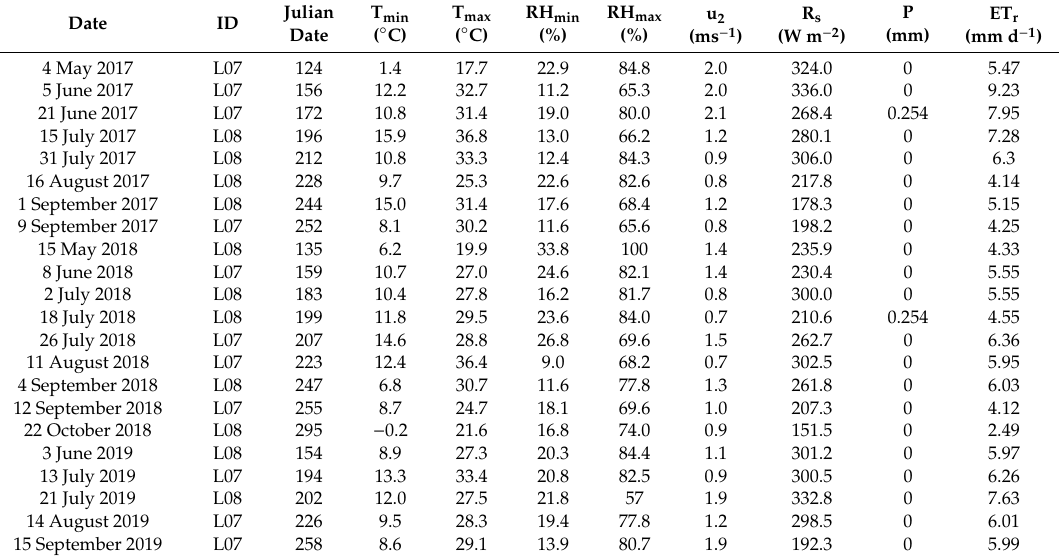
Table 1. Image acquisition date, spacecraft ID, and daily weather parameters measured at BREBS station, Powell Research and Extension Center, Wyoming. Daily weather parameters include minimum air temperature (T min ), maximum air temperature (T max ), minimum relative humidity (RH min ), maximum relative humidity (RH max ), wind speed (u 2 ), solar radiation (R s ), precipitation (P), and ASCE PM alfalfa-reference evapotranspiration